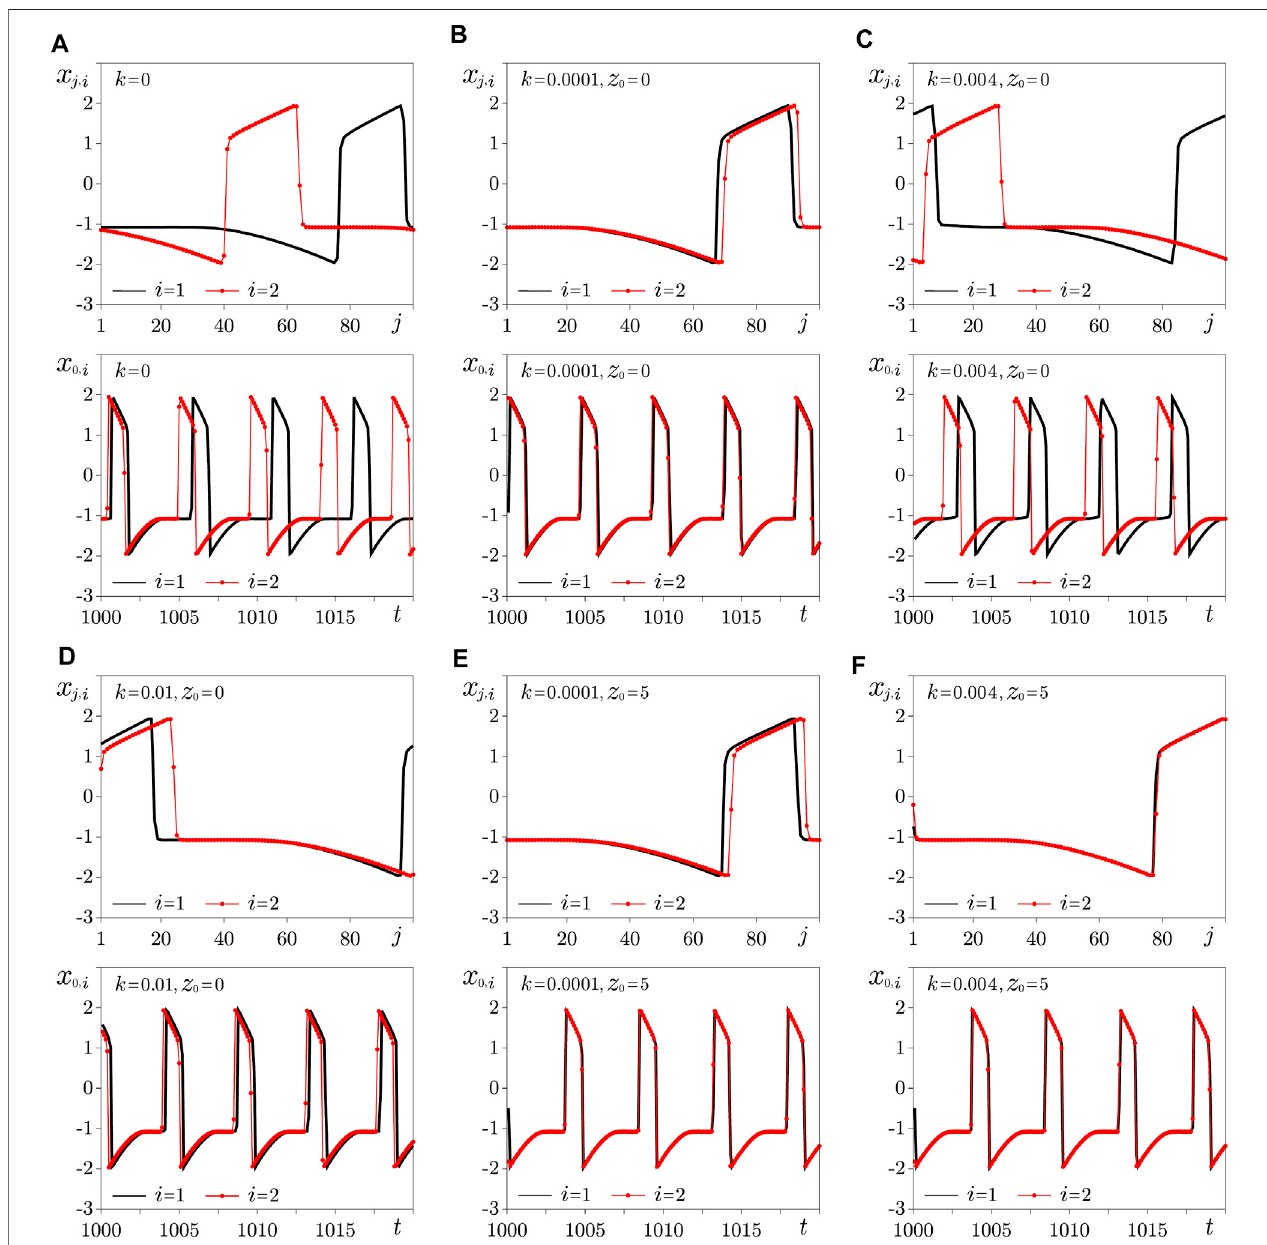
FIGURE4 | Pro fi lesoftravelingwaves(upperrow)and fl uctuations x 0, i ( t )ofoscillators(lowerrow)intwonon-identicalrings (Eq.2) intheabsenceofinterlayercoupling k =0 (A) ; in the case of z 0 = 0 with k = 0.0001 (B) , k = 0.004 (C) , k = 0.01 (D) ; in the case of z 0 = 5.0 for k = 0.0001 (E) and k = 0.004 (F) . Parameters: σ 1 = 4.5, σ 2 = 5.5, δ =